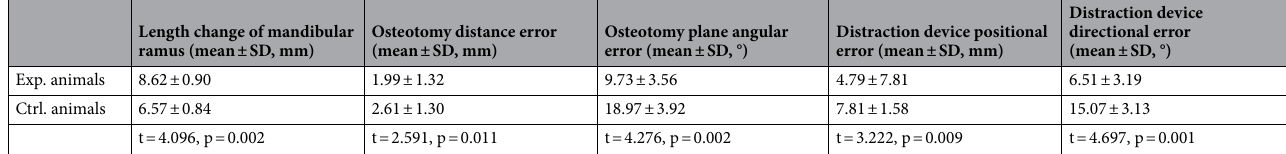
Table 1. Postoperative results and accuracy assessment. Exp. Experimental, Ctrl.